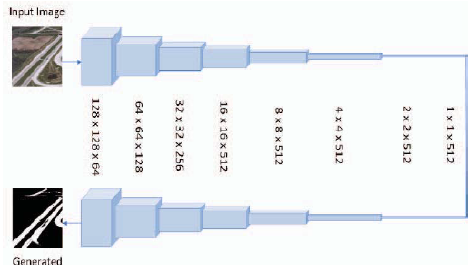
Figure 5. GANs-UNet generator function’s architecture from (Isola et al., 2017).